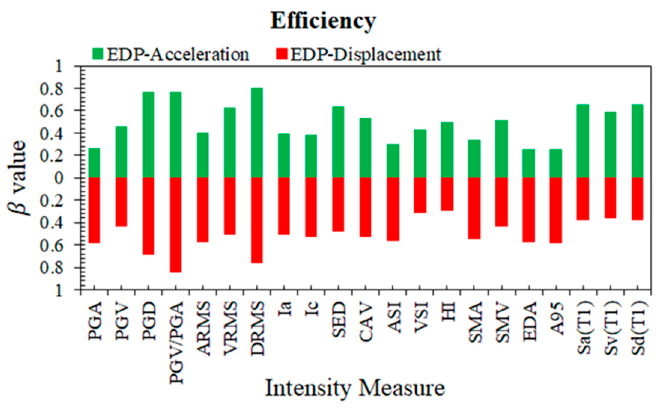
Figure 8. Efficiency comparison.